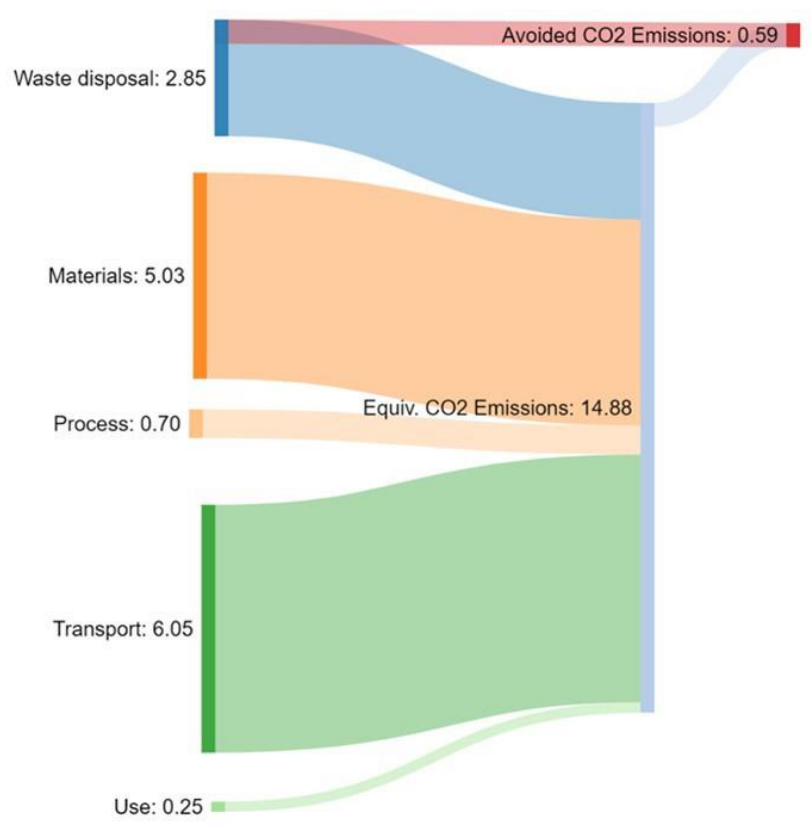
Figure 4. CO 2 emissions of 100 kg of greenhouse tomatoes per life cycle stage, including avoided emissions (in kg).